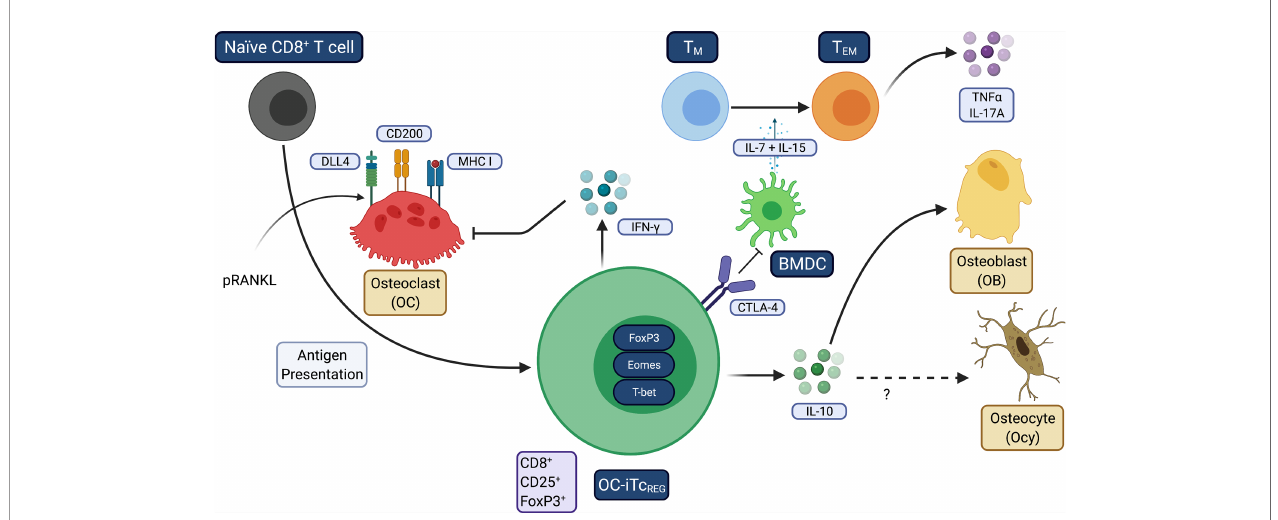
FIGURE 3 | Osteoclasts induce tolerogenic Tc REG. This fi gure summarizes how OC induce Tc REG to promote restore homeostasis under in fl ammatory conditions. OC use three signals: antigen-loaded MHC I that ligates TCR on CD8 T-cells, CD200 (a costimulation molecule that activates NF- k B) and the Notch ligand DLL4 that engages Notch1 and Notch4 on the T-cells. TNF a and/or IL-17A downregulate DLL4 expression on OC. Treatment with pRANKL leads to increased expression DLL4. Tc REG secrete IFN- g that suppress osteoclastogenesis by degrading TRAF6 and also suppress resorption by mature OC. Tc REG also secrete IL-10, which is required for the bone anabolic activity but not resolution of in fl ammation. IL-10 may also target Ocy to improve cortical bone mass. Resolution of in fl ammation appears to be mediated by CTLA4 expressed on Tc REG